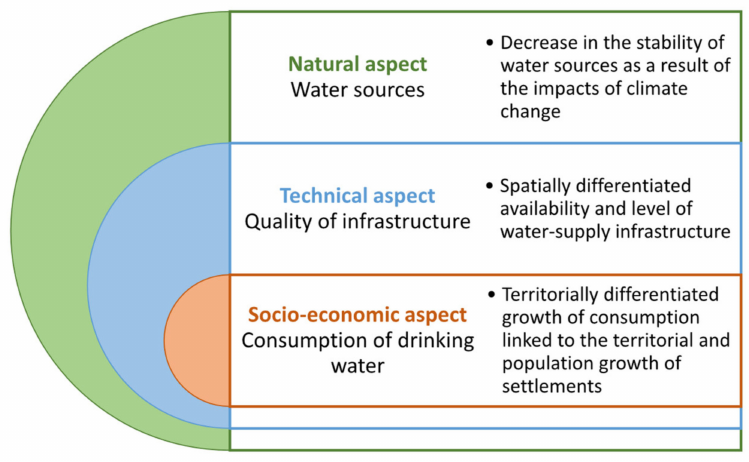
Figure 1. Basic aspects of drinking water supply problems in the Czech